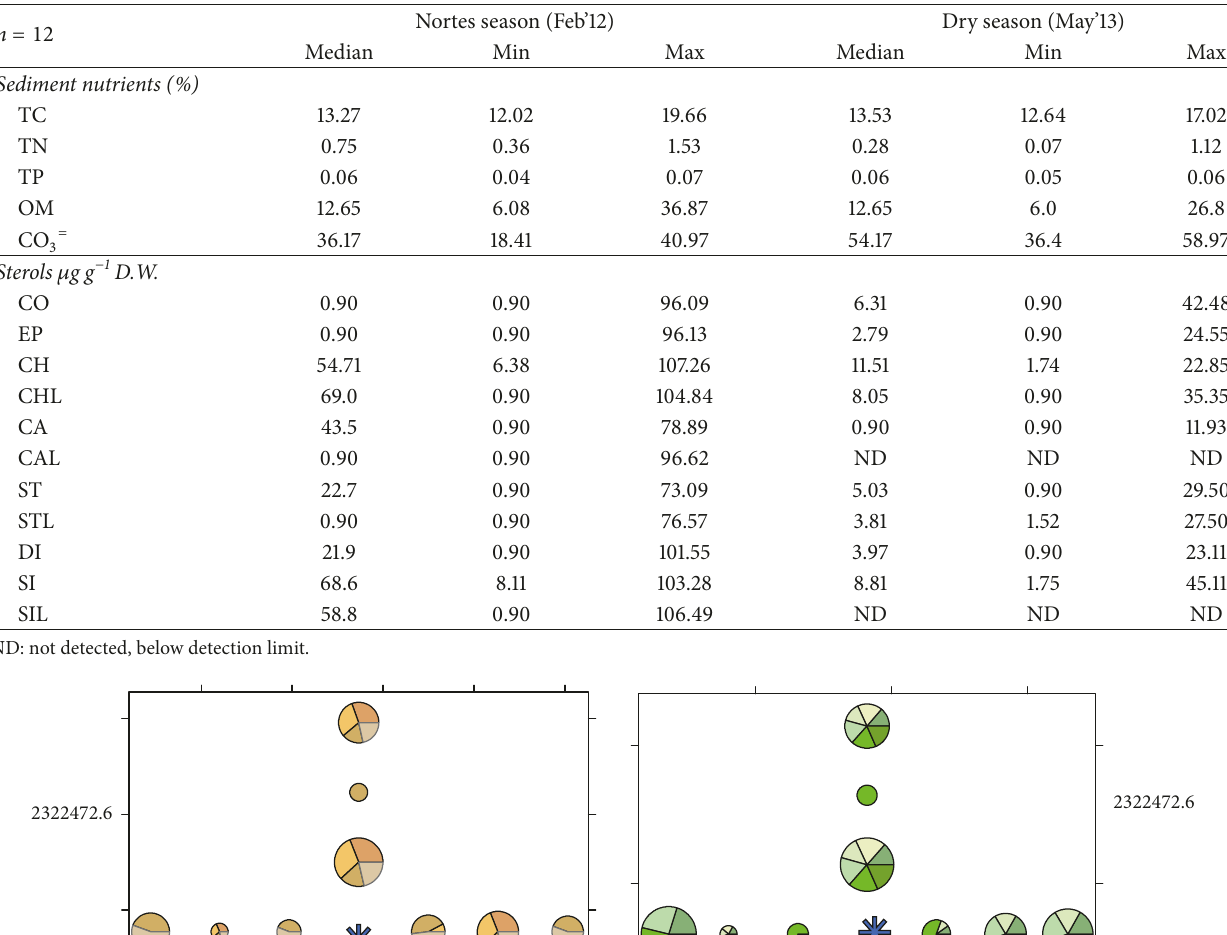
Table 2: Nortes and dry seasons median, minimum, and maximum ( 𝑁 = 12 ) nutrient content (%), sterols, and stanols ( 𝜇 gg −1 D.W.) in sediments surrounding X’Buya-Ha. TC: total carbon; TN: total nitrogen; TP: total phosphorus; OM: organic matter; CO 3= : carbonates; CO: coprostanol; EP: epicoprostanol; CH: cholesterol; CHL: cholestanol; CA: campesterol; CAL: campestanol; ST: stigmasterol; STL: stigmastanol;